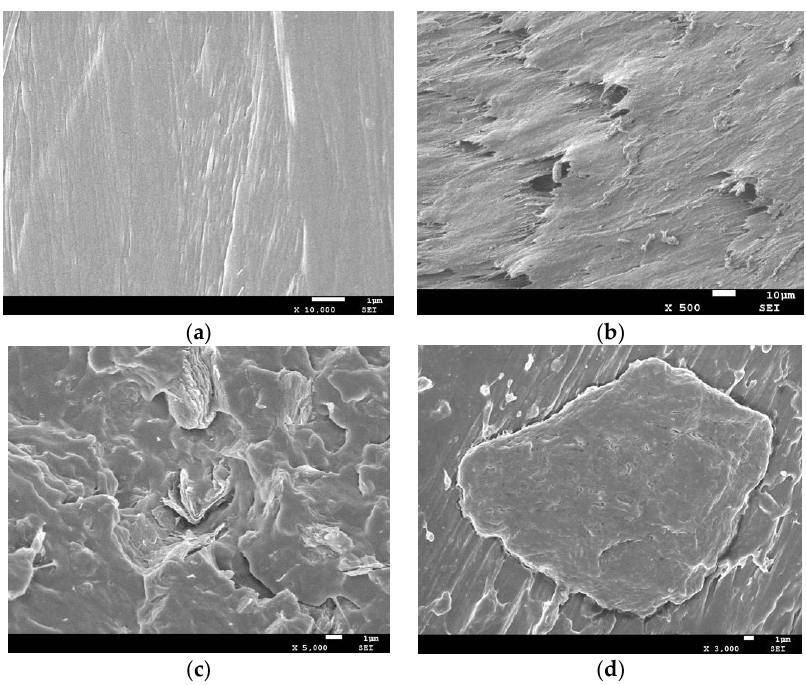
Figure 3. SEM cross section of pure PLA absorber and graphene/PLA composite absorbers. ( a ) Pure PLA absorber; ( b ) 5 wt% graphene/PLA composite absorber; ( c ) 7 wt% graphene/PLA composite absorber; and ( d ) 9 wt% graphene/PLA composite absorber.